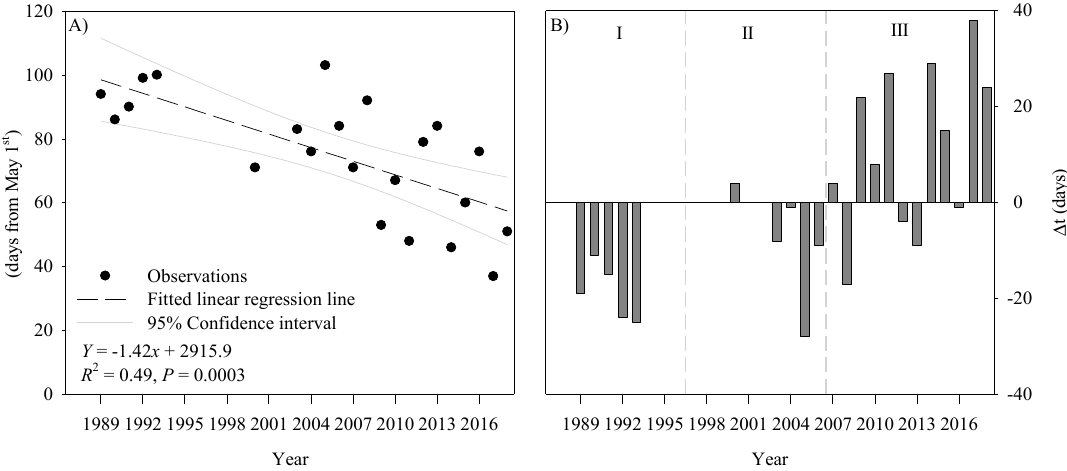
Figure 2. Plots against Year for ( A ) the earliest time of ODM observation from 1 May, with linear regression analysis results, and ( B ) the difference between the average first observation date and the first observation date for each year during which ODM was observed.